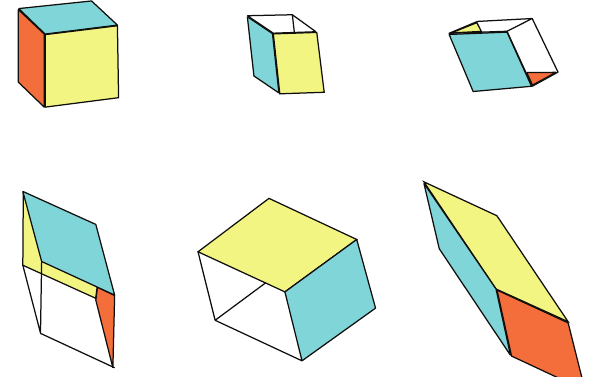
Figure 3: Geometrical visualization of LTC between equivalent systems; see